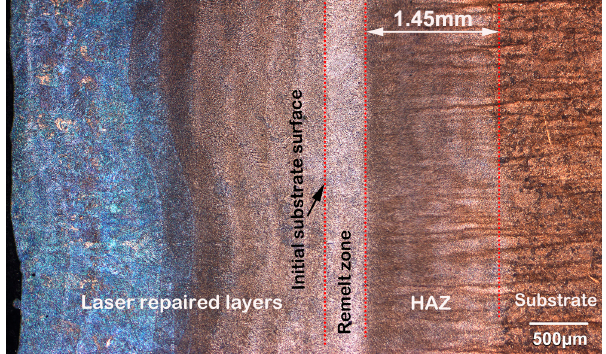
Figure 5. The cross-section of the top region in 20-layer LFR sample.